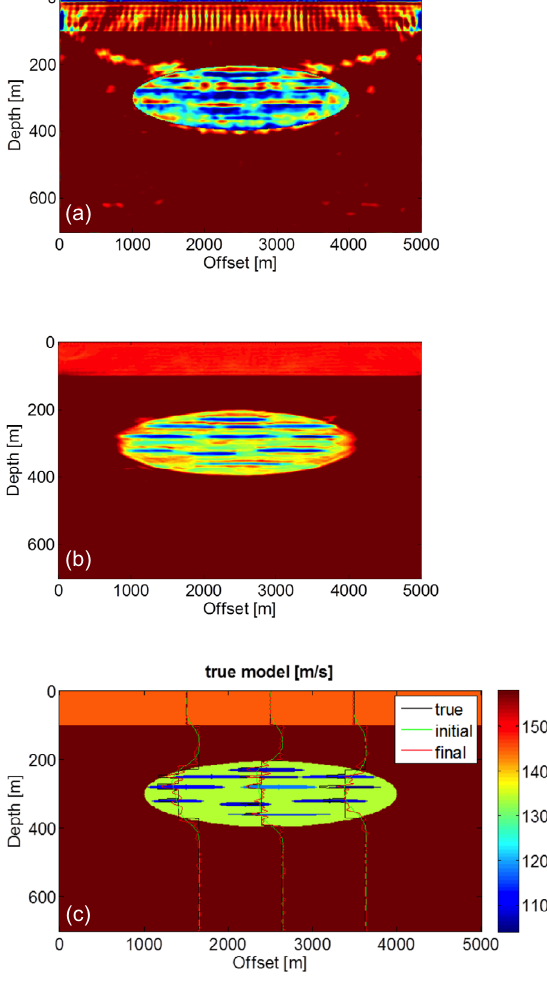
Figure 5. (a) Full waveform inversion result using conventional ap- proach (least-squares technique); (b) full waveform inversion result using the proposed approach; (c) misfit plot with the proposed ap- proach (red color). The inversion results are well fit with the true model.